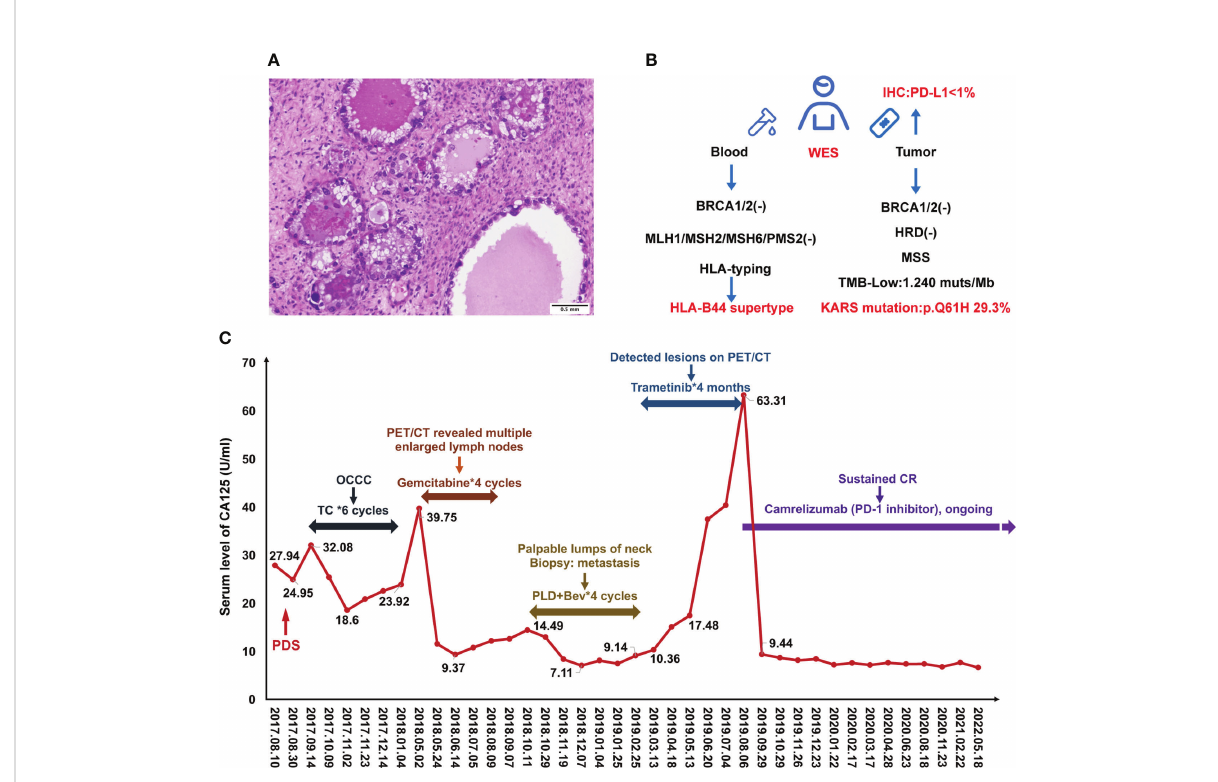
FIGURE 1 Case presentation during treatment. (A) H&E staining of ovarian clear cell carcinoma. (B) Scheme of molecular testing strategy. (C) Change of serum CA125 levels during the